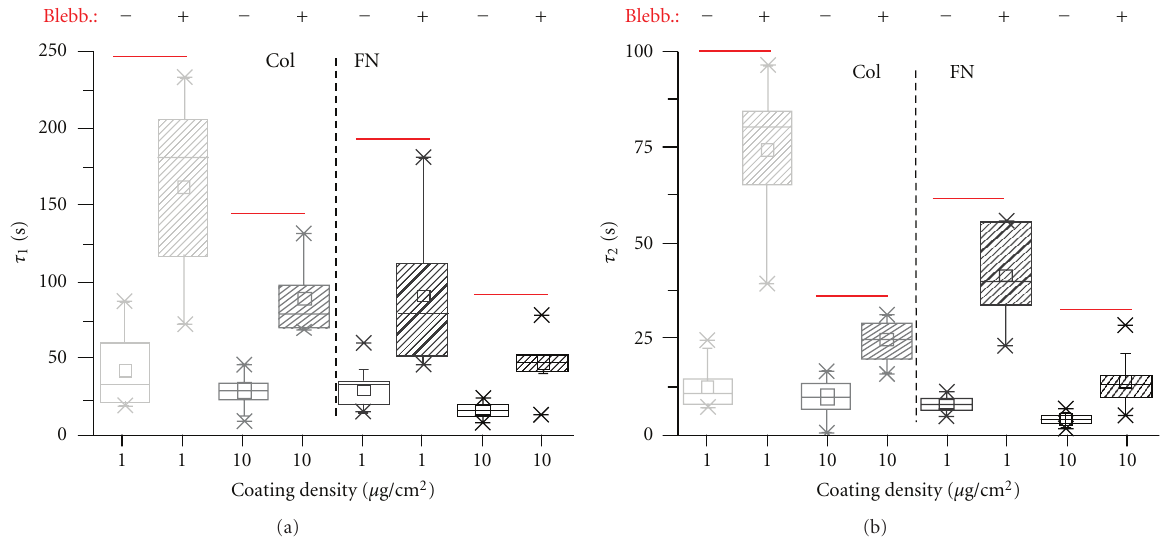
Figure 6: E ff ect of nonmuscle myosin II inhibition on deadhesion dynamics of MDA-MB-231 cells. MDA-MB-231 cells were incubated with 5 μ M blebbistatin for 30 mins prior to deadhesion. ((a), (b)) Blebbistatin treatment led to a significant delay in deadhesion dynamics of MDA-MB-231 cells across all the conditions. Di ff erences in τ 1 and τ 2 between untreated cells and blebbistatin-treated cells were statistically significant for all the conditions ( ∗ P < 0 . 05).